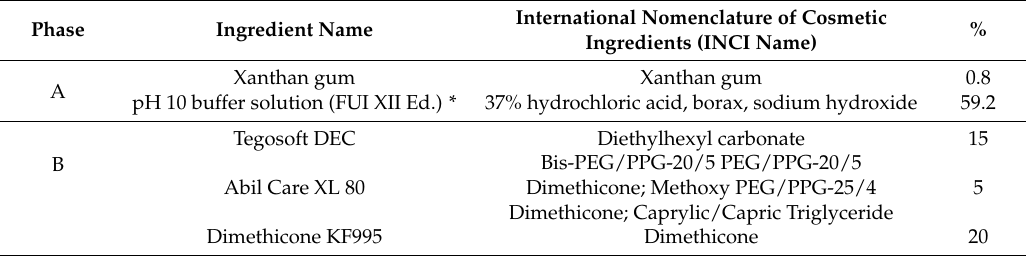
Table 1. Qualitative and quantitative simulant composition used to fill the low-density polyethylene (LDPE) and linear low-density polyethylene (LLDPE) single dose